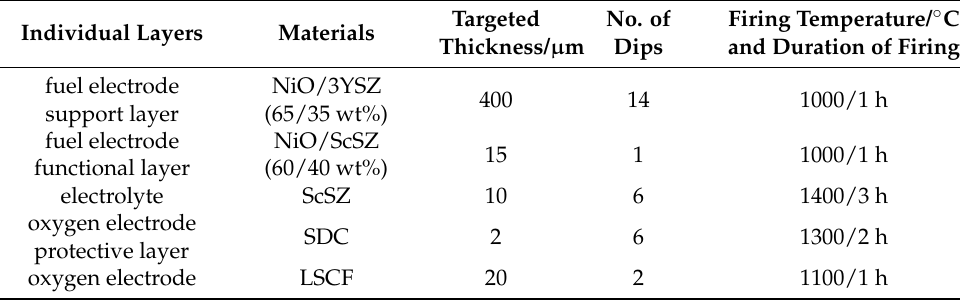
Table 1. Summarized conditions for the fabrication of SOC